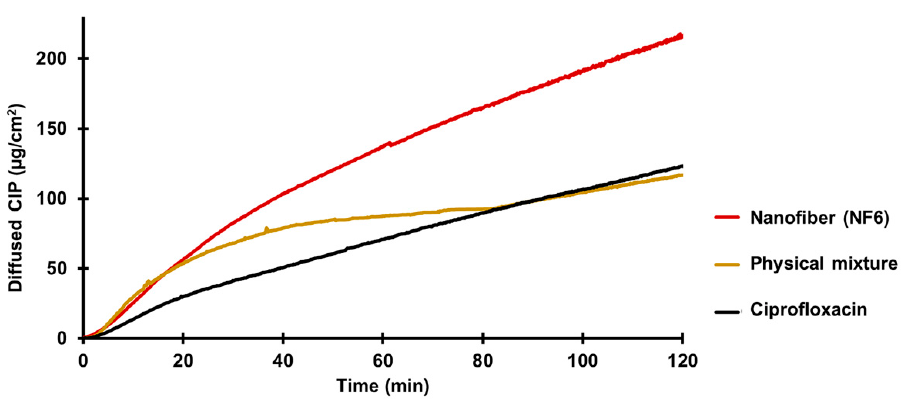
Figure 6. In vitro diffusion of ciprofloxacin (CIP) from the NF6 nanofibrous sample, physical mixture, and CIP powder (SD ± 2%). The calculated flux ( J ) and permeability coefficient ( K p ) values are shown in Table 7.